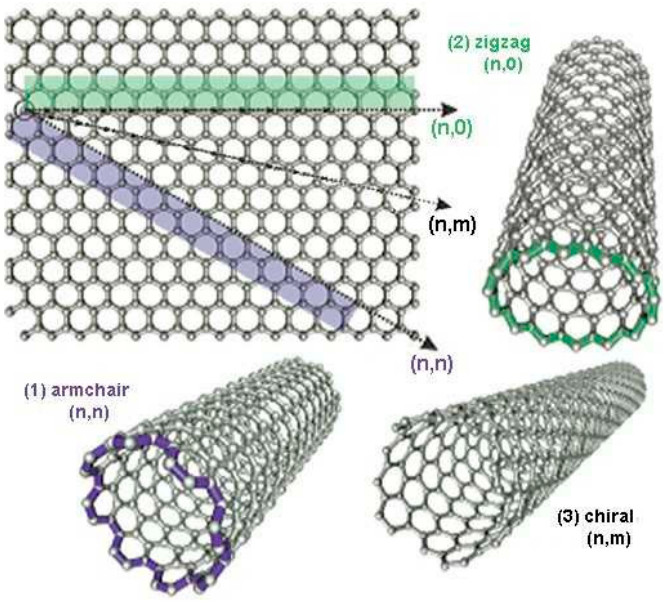
Figure 1. The imaginative process of forming a SWCNT by rolling a graphene sheet in different Figure 1. directions.